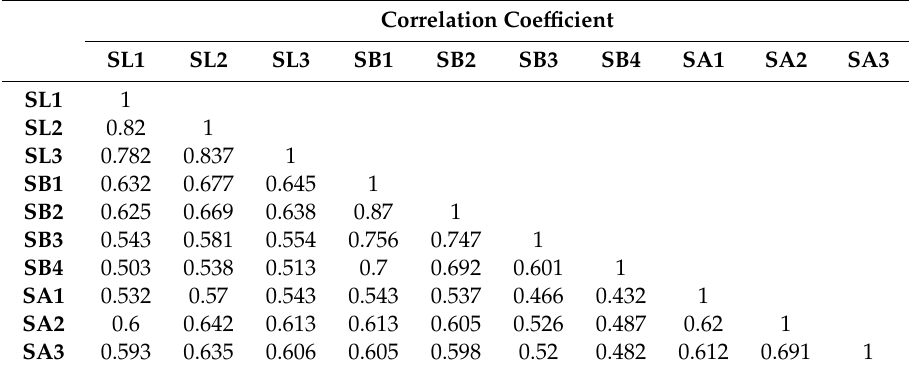
Table 7. Correlations analysis for all significant dimensions of SA, SL and